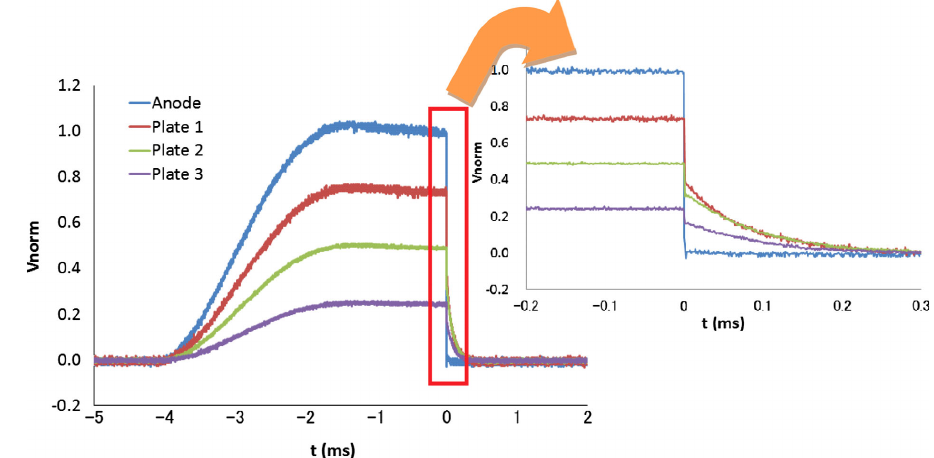
FIG. 12. Voltage waveforms measured at the anode and the intermediate electrodes, and zoomed-up waveforms around the falling edge of the voltage pulse are also shown in the upper right.